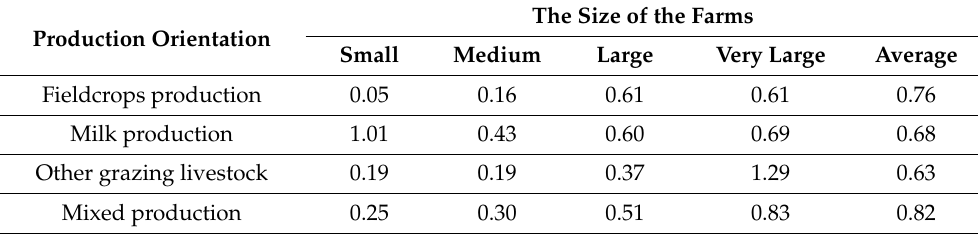
Table 8. Capital productivity (2015–2020 average).